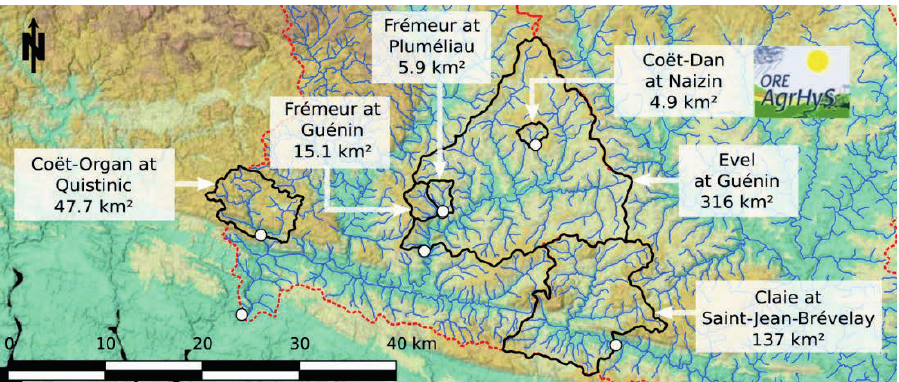
Fig. 1 Map of the studied basins surrounding the Coët-Dan at Naizin long-term monitored basin.